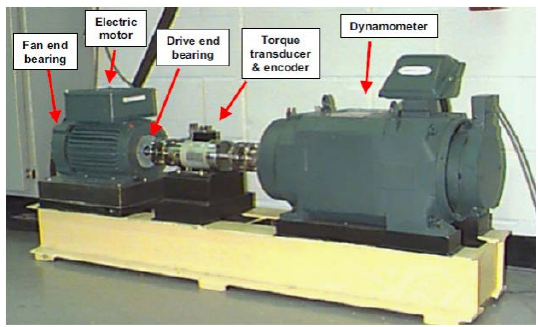
Figure 1. The testbed of CWRUBD to collect the data [27].